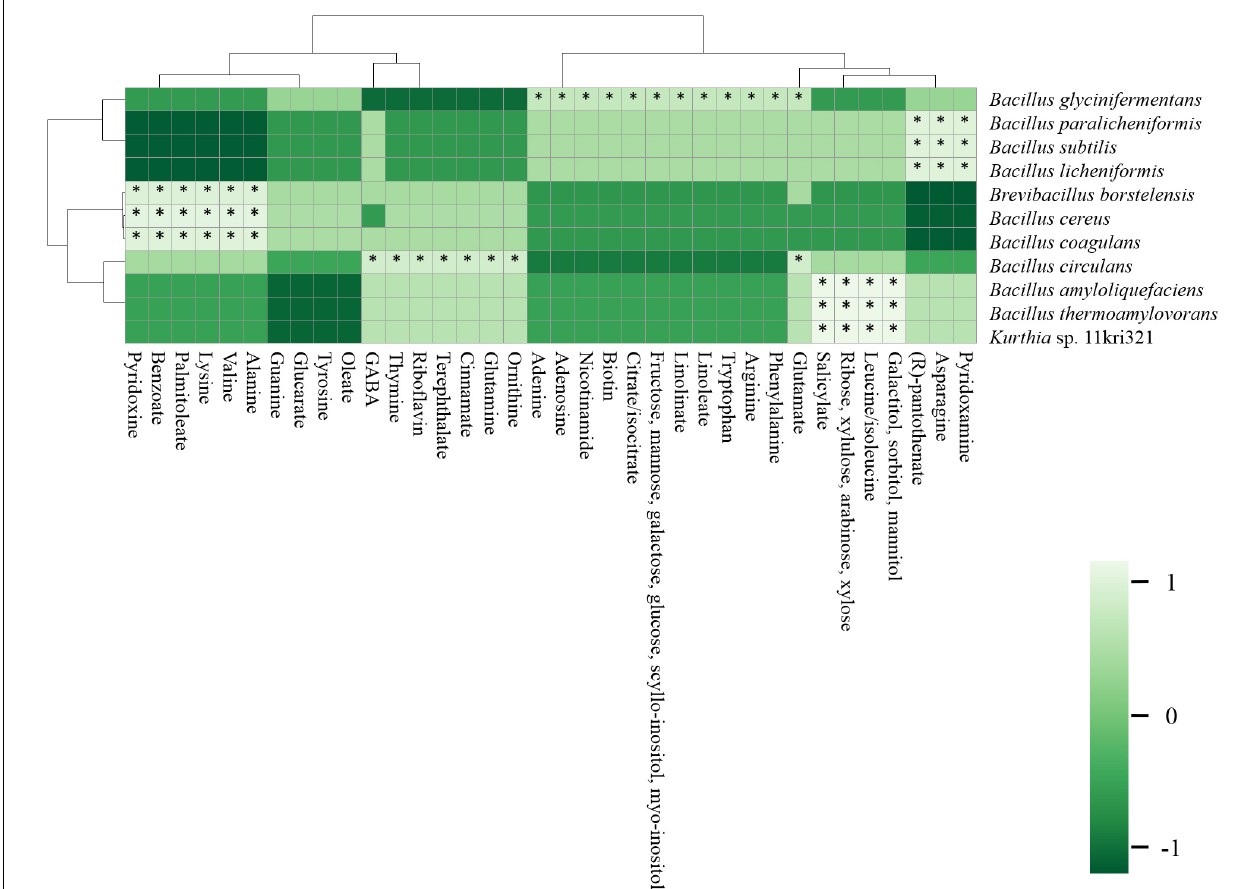
FIGURE 12 | A correlation analysis between abundant species ( > 1%) and primary metabolites (amino acids, fatty acids, organic acids, sugars, vitamins, and nucleobases) using Spearman’s correlation constructed by Clustvis.